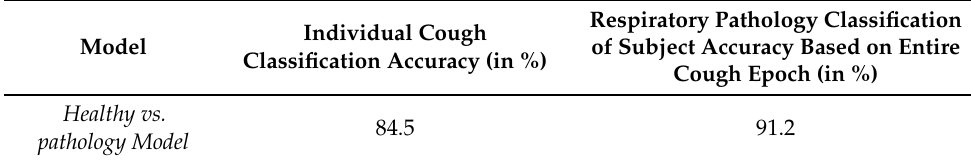
Table 3. Accuracy of the Healthy vs. Pathology